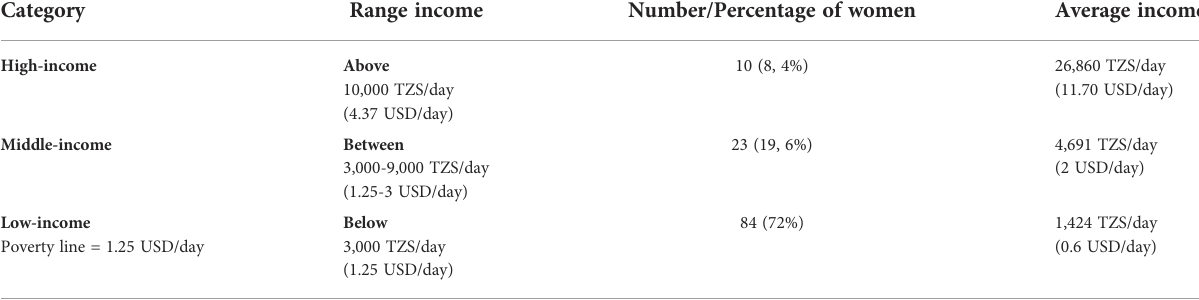
TABLE 2 Income categorization for the women interviewed during the study along coastal villages in Zanzibar, Tanzania (N=117).